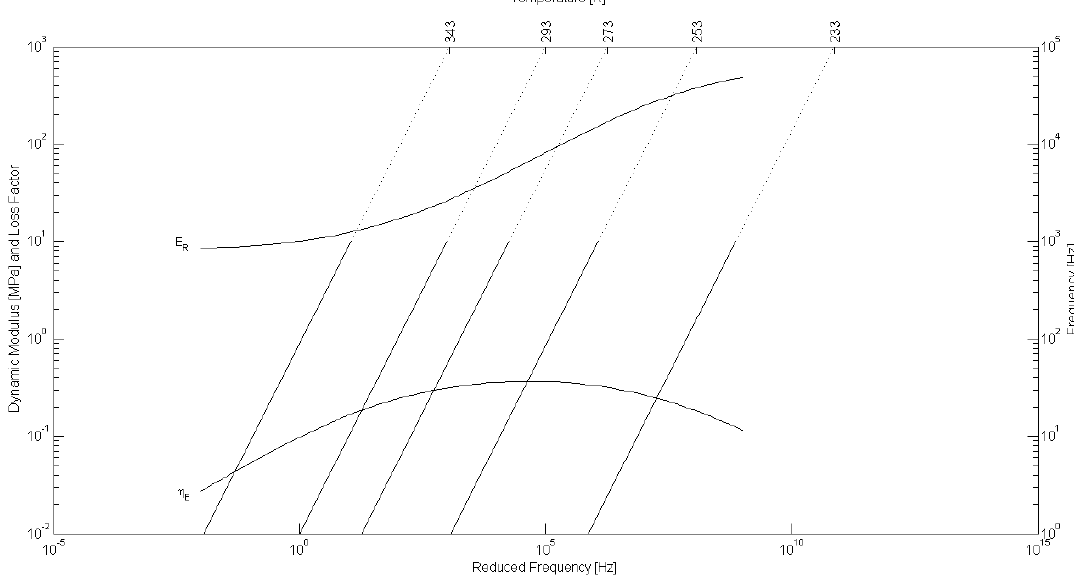
Figure A4. Reduced-frequency nomogram for Butyl Rubber BT 806-55; λ = 0.88 [29].